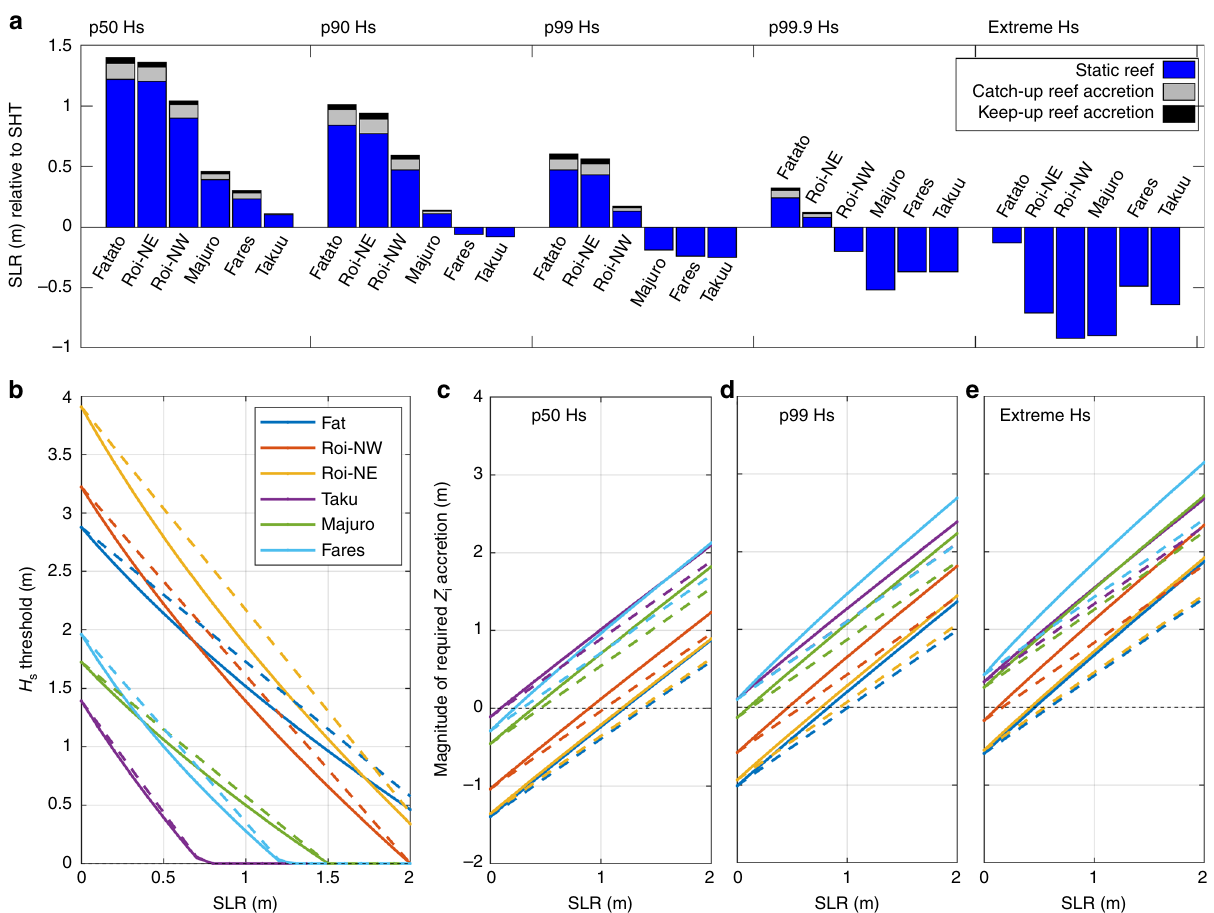
Fig. 4 Threshold conditions for wave overtopping on atoll islands with different reef response scenarios. a Sea-level rise thresholds for wave overtopping on different atoll islands with no reef response, a catch-up and a keep-up reef responses, for different wave conditions that are speci fi c to each island. b Threshold incident wave heights that will cause overtopping at spring high tide on different atoll islands for a range of future SLR magnitudes. Solid lines represent no reef adjustment and dashed lines represent a keep-up reef response. c – e The magnitude of vertical island accretion required to prevent wave overtopping at different magnitudes of SLR for different wave conditions. Note that the average gradient of solid lines (no reef response) is 1.2 compared to a gradient of 1.0 for dashed lines (keep-up reef